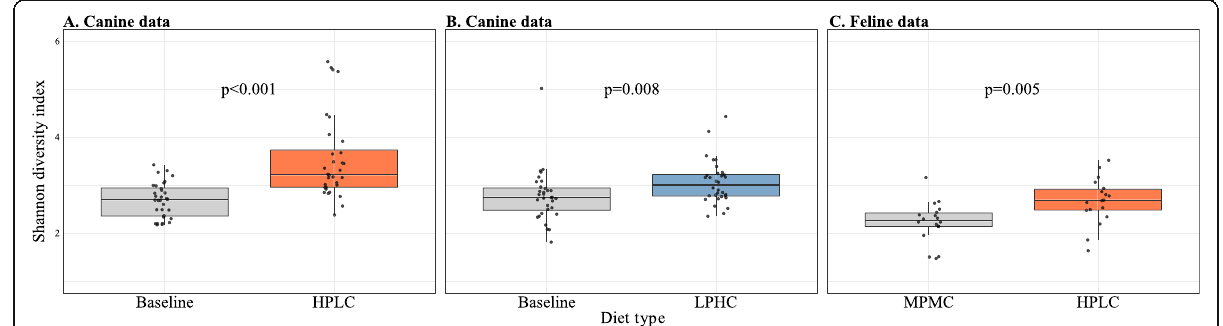
Fig. 2 The Shannon diversity index before and after intervention with HPLC ( a ) and LPHC ( b ) diets in the canine data, and between different MPMC and HPLC diet groups in the feline data ( c ). Non-parametric statistical methods were used. For the canine data, the Wilcoxon signed-rank test was used since samples collected from the same animals comprised different diet groups. For the feline data, the Wilcoxon rank-sum test was